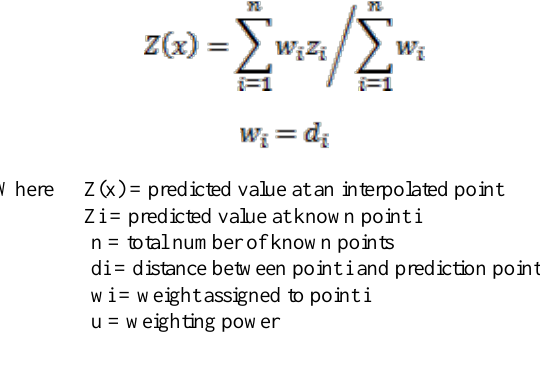
Figure 2. Annual leptospirosis incidence in Guilan province. Figure 3. The annual average leptospirosis incidences of